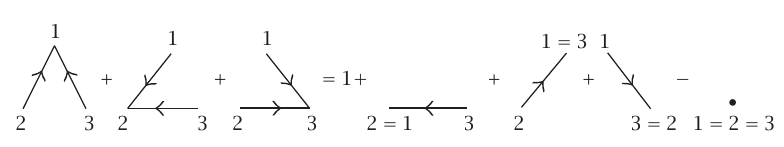
Figure 3.1 . Three-point